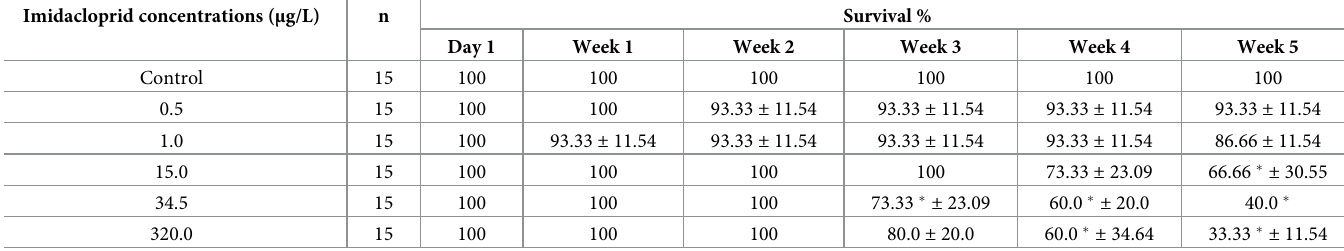
n = number of shrimp individuals in each treatment (5 shrimp per replicate aquarium, 3 aquariums per treatment). Values with star ( � ) indicate treatment is significantly different from the control (P <